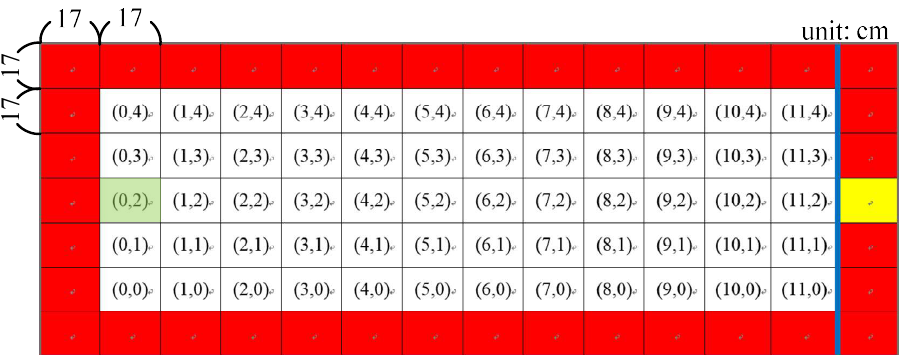
Figure 4. Mechanism and dimensions of the automatic training platform and the HSV color space for the captured image.